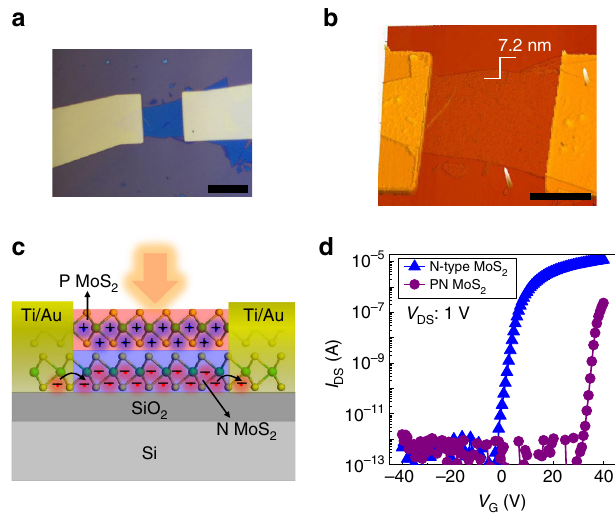
Fig. 1 MoS 2 -based phototransistors with an out-of-plane PN homojunction. a Optical microscopy image of the few layer MoS 2 -based device with Ti/Au as source and drain electrodes, the scale bar is 20 µ m. b Atomic force microscopy image of the device depicting a thickness of 7.2 nm. The scale bar is 10 µ m. c Schematic diagram of the device after surface doping under light illumination consisting of P-MoS 2 on top surface and N-MoS 2 underneath. The photo-excited holes remain trapped in P-MoS 2 while the electrons transport and recirculate in N-MoS 2 channel. d Transfer characteristics of the pure N-MoS 2 detector and surface doped device